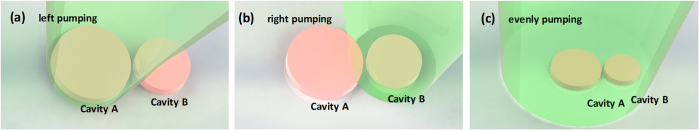
Schematic of three different pumping schemes.